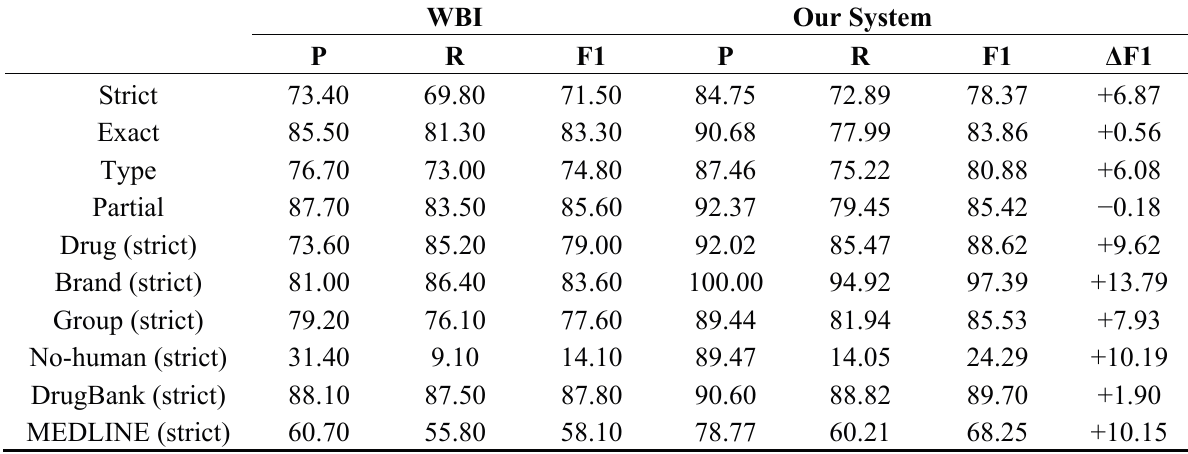
Table 4. Detailed comparison between our system and the best system of DDIExtraction 2013